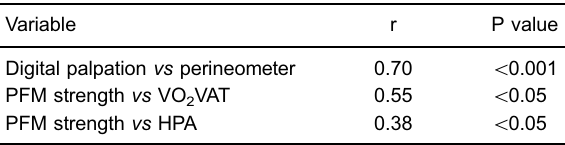
Table 2. Results of the correlation analysis between relevant